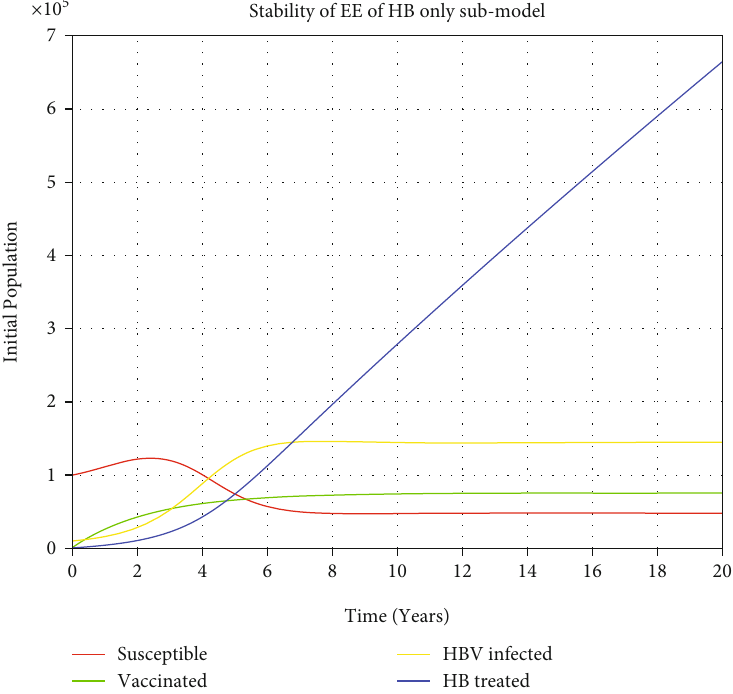
= 2 : 37 , ω = 0 : 95 , and q = 0 : 4 B eff